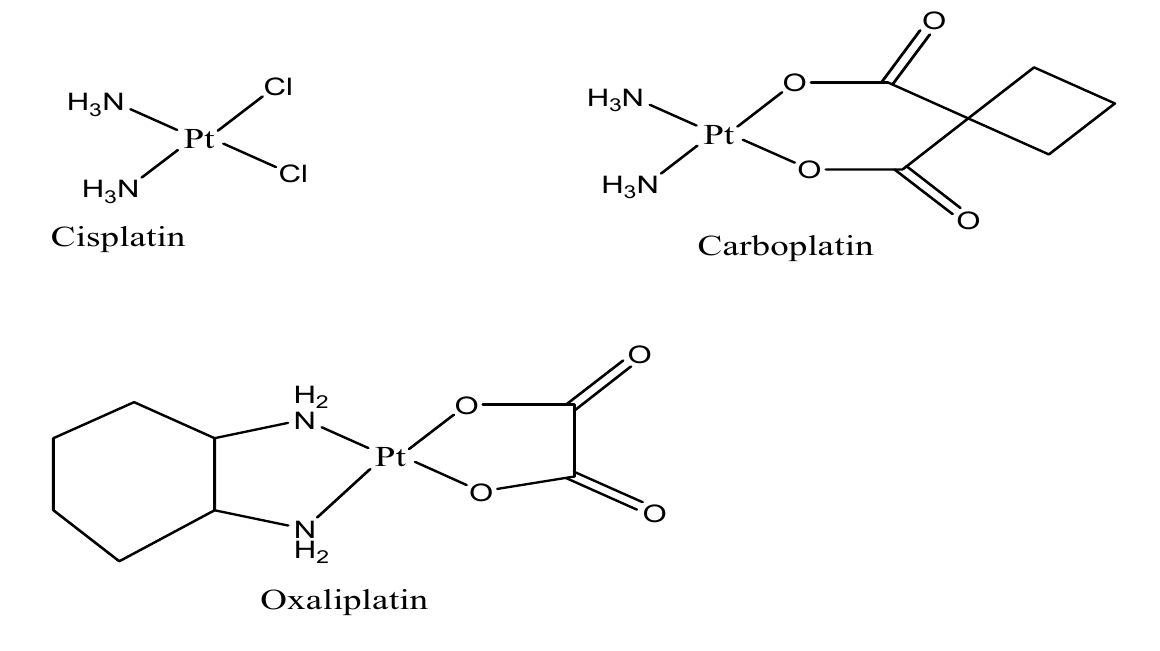
Cl BBR3464 Figure 2. Unclassical platinum drugs that have been formulated. Carboplatin is a second-generation platinum drug that has a broad scope of anti- tumor activity. The platinum metals are complexed with a cyclobutane-dicarboxyl back- bone and two ammonia groups in carboplatin. The compound is activated intracellularly, generating platinum complexes that are reactive, binding to the nucleophilic groups of the DNA, which include interstrand DNA cross-links, GC-rich sites, and triggering in- trastrand as well as DNA-protein cross-links. Cell growth and apoptosis reduction are mediated by protein and carboplatin-induced DNA interactions. This drug has cytotoxic effects that are comparable to its natural substrate, cisplatin, but it is more stable and re- duces the adverse effects. For oxaliplatin, also known as (trans-R,R-cyclohexane-1,2-diamine) oxalatoplati- num(II), a platinum-containing third-generation therapeutic in some cancers, cross-re- sistance with cisplatin has been reported [34]. It induces intrastrand crosslinks, DNA-pro- tein crosslinks, and also interstrand crosslinks with cellular DNA. It exhibits similar